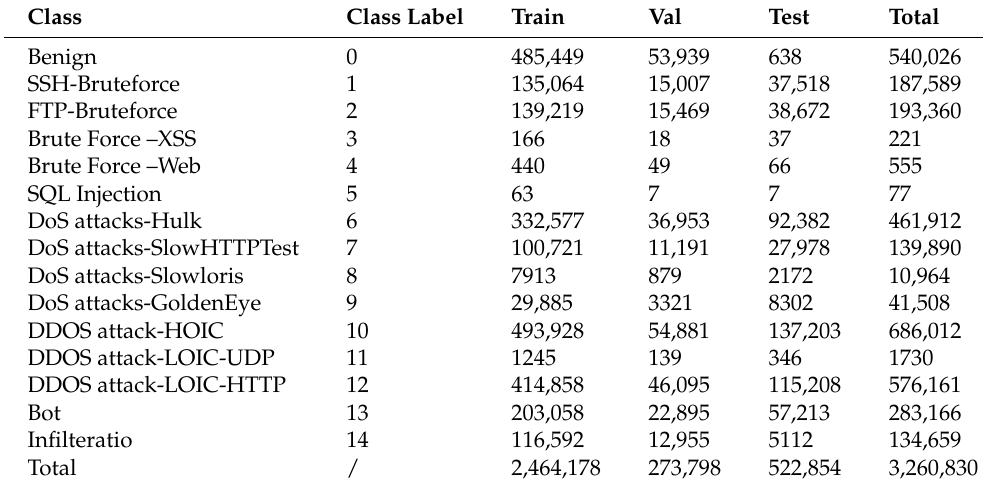
Table 5. Sample distribution of the training, validation, and test sets in Stage-2.